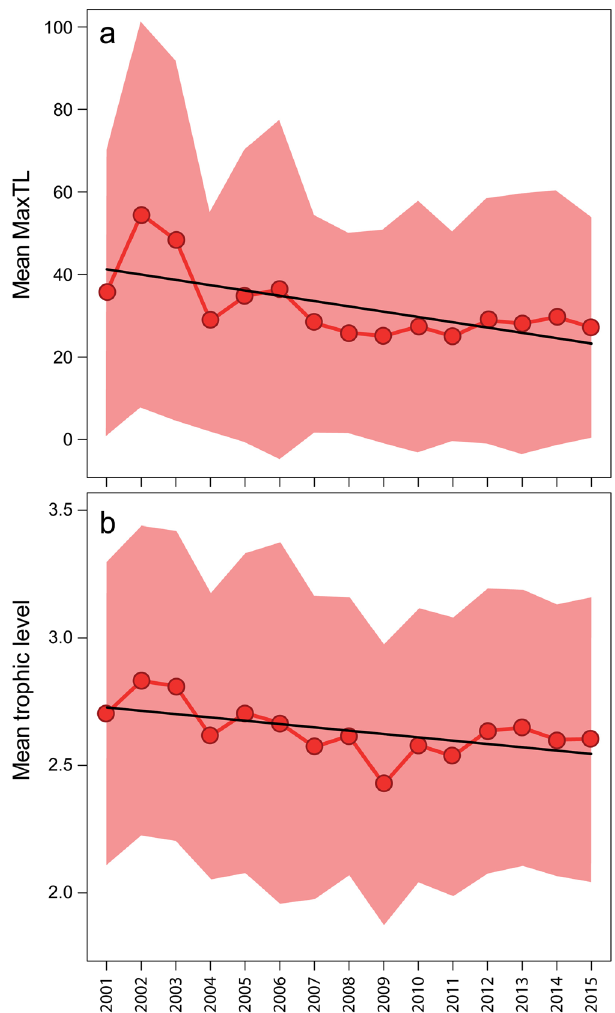
Figure 3. Weighted mean: ( a ) maximum total length (maxTL) and ( b ) trophic level in seasonal catches of the Dai fishery from the fishing season of 2000/01 to 2014/15. For model summary ( a ), intercept = 42.53, slope = − 1.29, predictor p-value = 0.007, r 2 = 0.44. For model summary ( b ), intercept = 2.74, slope = − 0.013, predictor p-value = 0.025, r 2 = 0.33. Pink shaded area denotes standard deviation around the mean values. 2001 represents the fishing season of 2000/01 and the same for other